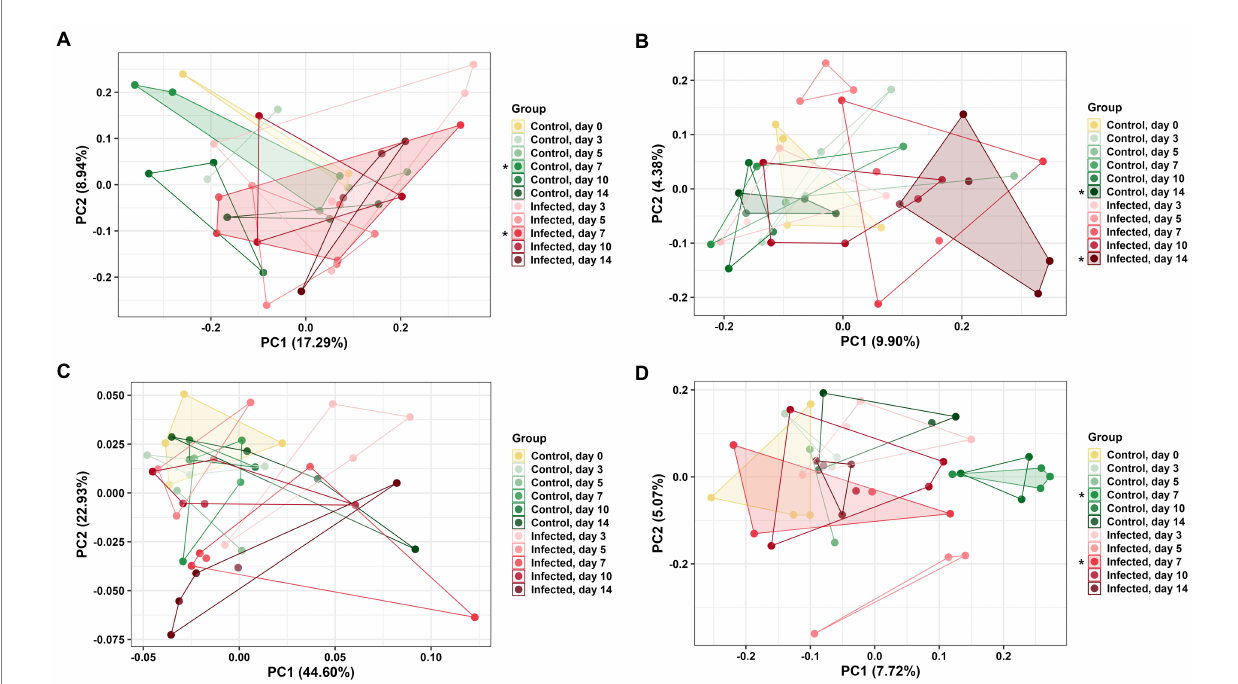
FIGURE 4 Principal coordinate analysis (PCoA) based on: (A) unweighted UniFrac distance matrix of duodenal luminal (DuoL) microbiota, (B) unweighted UniFrac and (C) weighted UniFrac distance matrices of duodenal mucosal (DuoM) microbiota, and (D) unweighted UniFrac distance matrix of jejunal mucosal microbiota (JejM). Stars (*) on legend denote microbiota were significantly different (PERMANOVA, p < 0.05) on those days. Longer distances between points indicate microbiota profiles were different, while shorter distances between points indicate profiles were